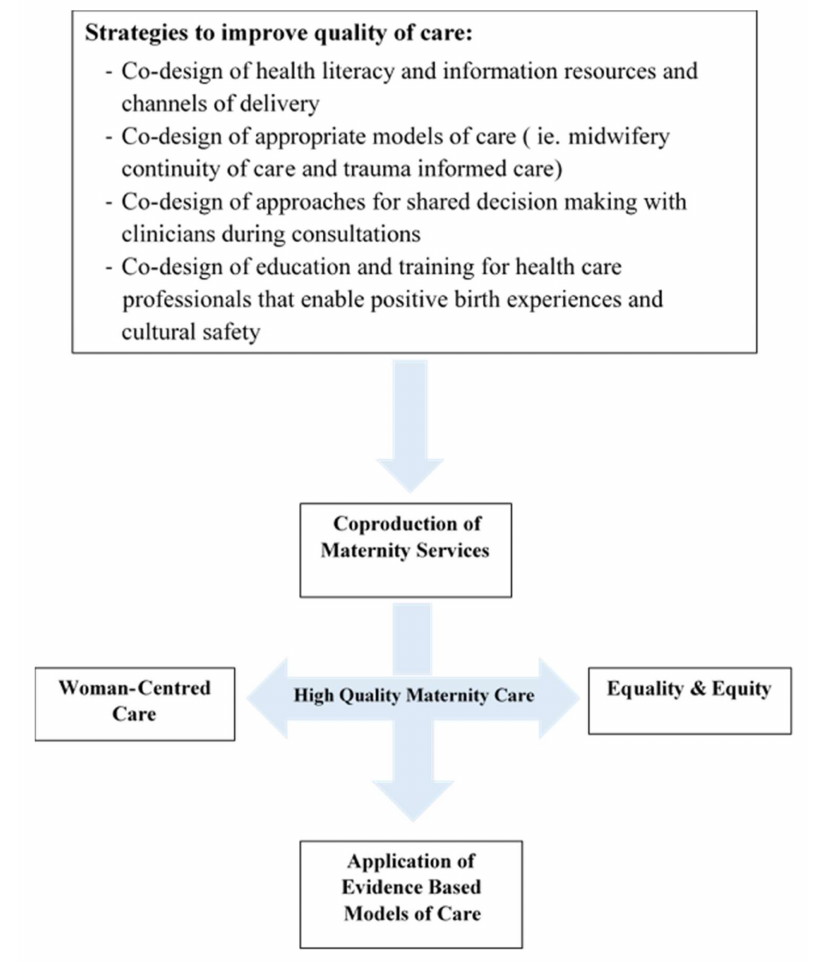
Figure 2. Conceptual model of quality improvement within maternity services for women with female genital mutilation